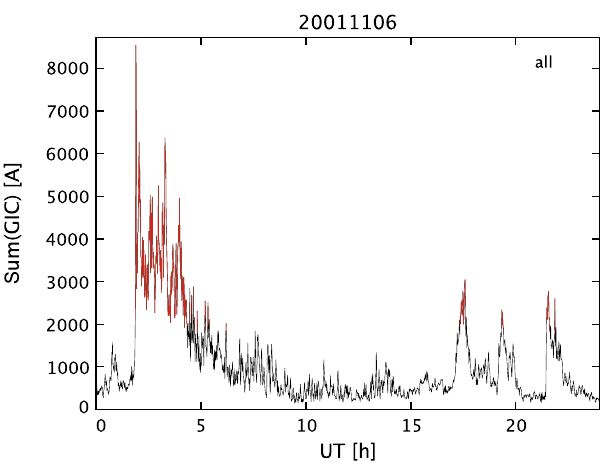
Fig. 10. Sum of GIC in the European high-voltage power grid on 6 November 2011. Red colour denotes periods when the sum exceeds the limit for the top 0.1% values (cf. Fig. 9). The longest sequence of large GIC lasts for 149